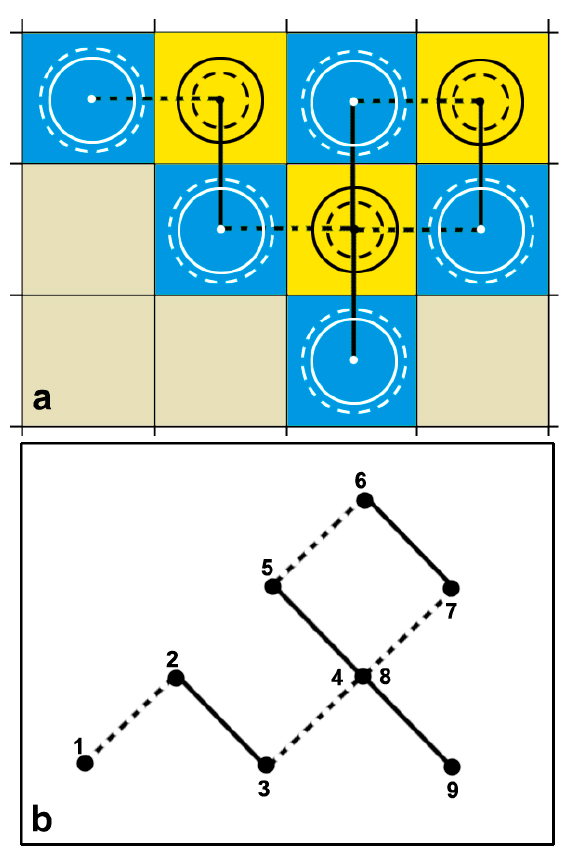
Figure 8. ( a ) A schematic representation of a bulk NB displacement, alternating from an oversaturated domain (blue) to an undersaturated domain (yellow) at equal times but with opposite perturbation conditions. Solid circles reflect the original size of the bubble, and broken circles indicate either expansion or contraction. Notice that the size of the average bubble is invariant. ( b ) The bubble performs a Brownian walk of an alternating Peano curve of fractal dimension H = 2.